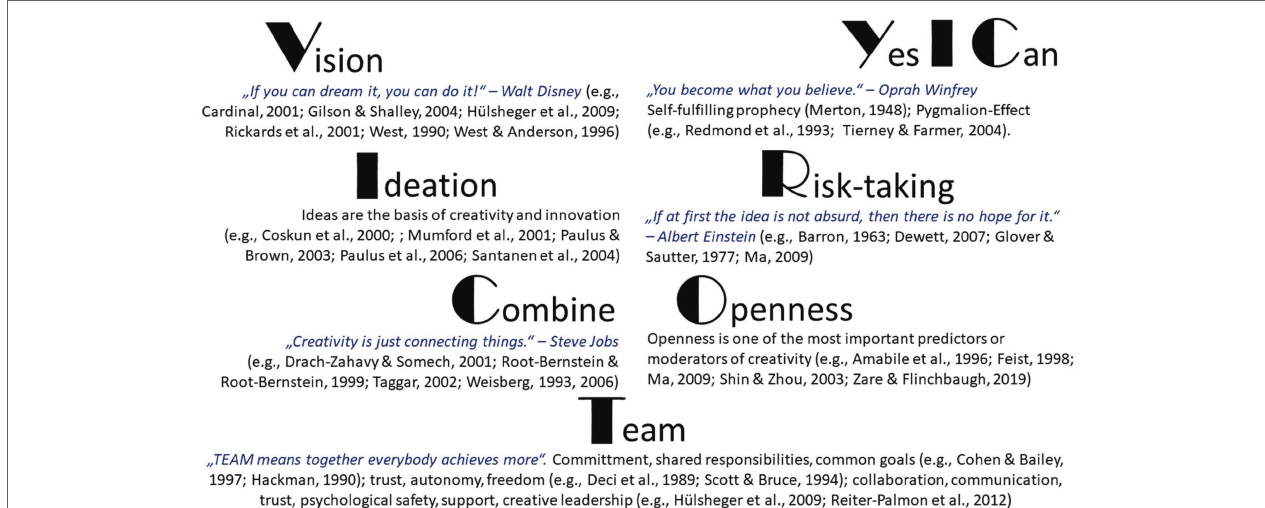
FIGURE 1 | The VICTORY model for team creativity